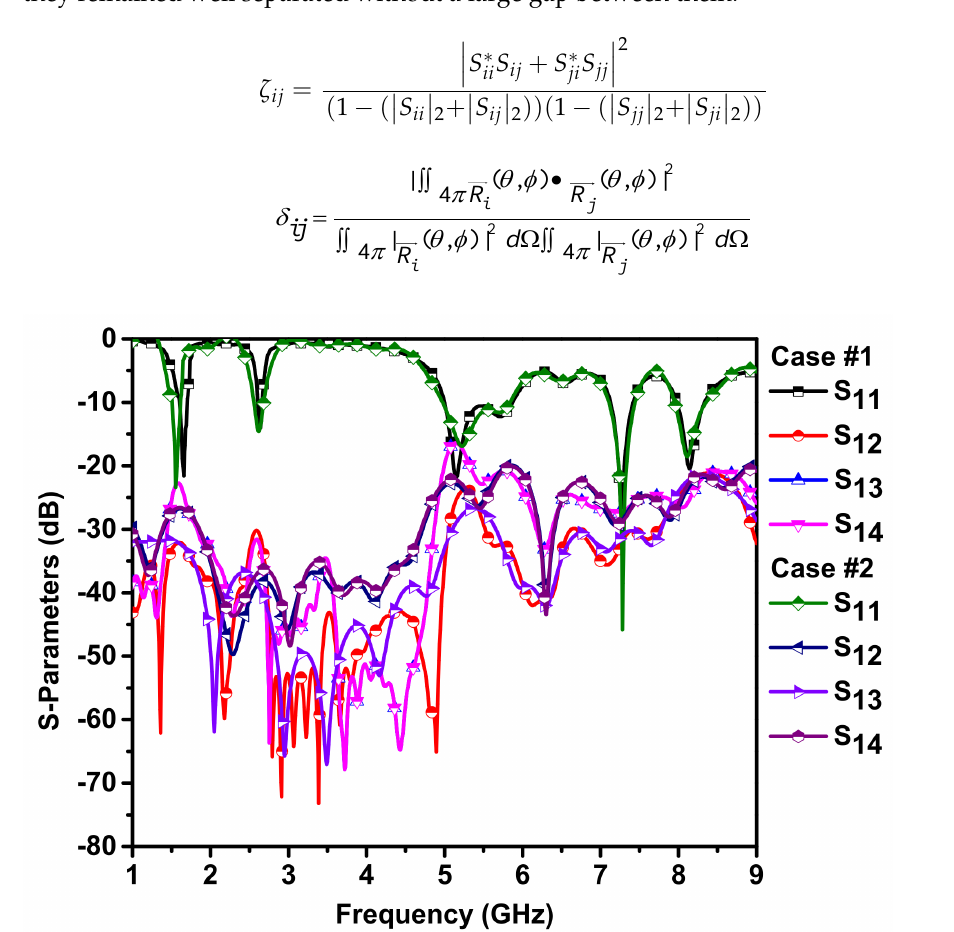
Figure 7. Pentaband MIMO antenna S-parameters comparison with and without a ground plane. In order to evaluate the diversity performance of the MIMO antenna, several parameters are considered, including ECC and DG. ECC can be calculated using either the covariance matrix or the correlation coefficient matrix. The covariance matrix represents the covariance between the received signals at different antenna elements, whereas the correlation coefficient matrix represents the correlation coefficient between the received signals. The correlation coefficient is normalized to values between − 1 and 1 and can be obtained by dividing the covariance matrix by the product of the standard deviations of the signals received by the antennas. In the context of wireless applications, ECC is a critical diversity parameter that can provide insights into the correlation between